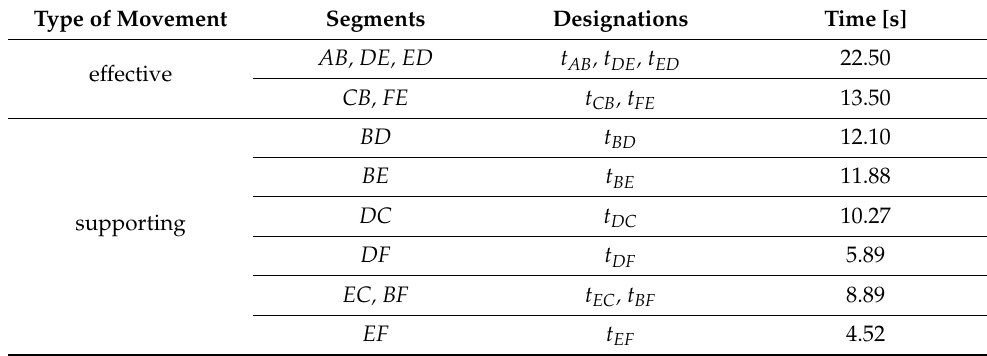
Table 2. Times of individual movements of the